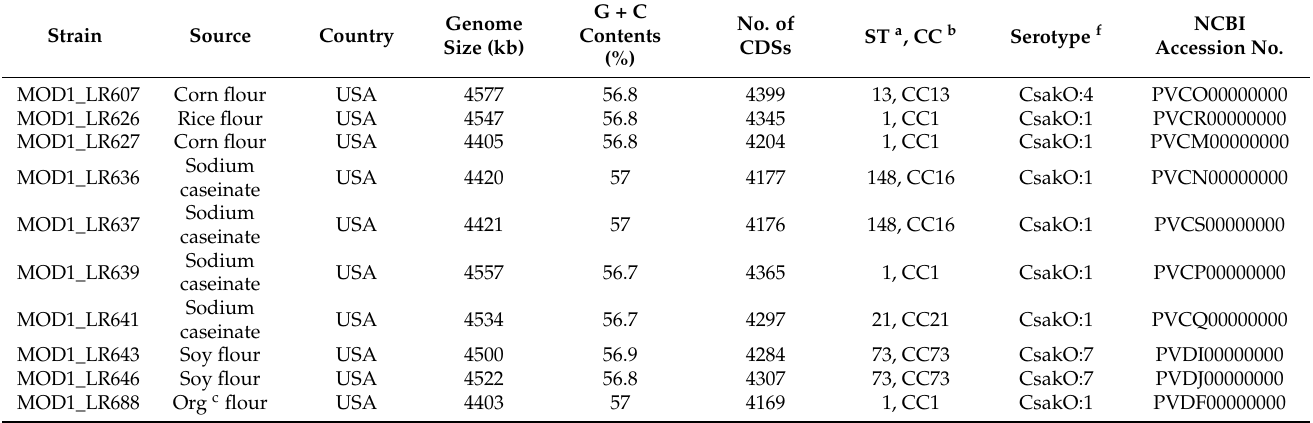
Table 1. Strain name, source, country of origin, genome size, G + C% content, number of Coding DNA sequences (CDS), sequence type (ST), serotype, and NCBI GenBank accession numbers of 33 C. sakazakii isolates obtained from plant-origin foods and sequenced in this